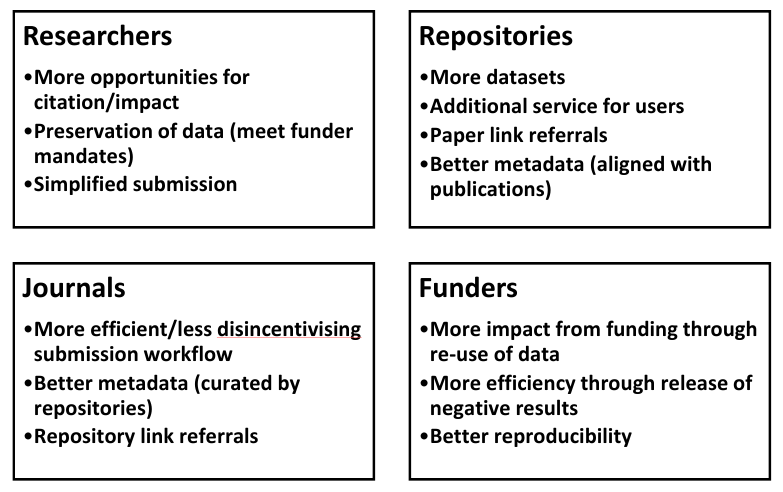
Figure 2. Data2paper Stakeholder benefits.